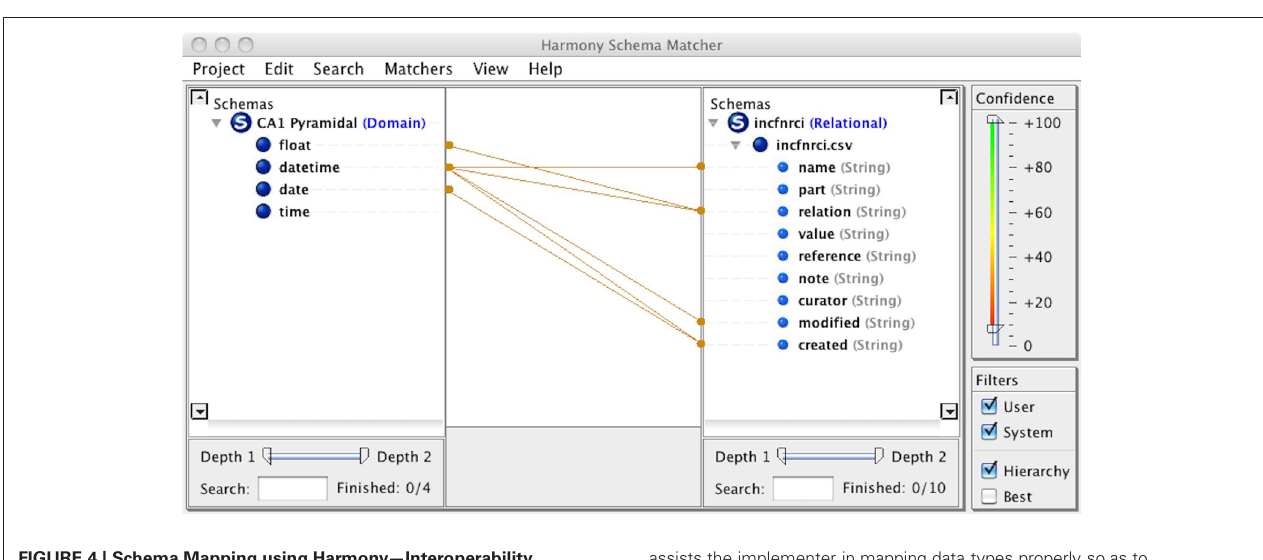
FIGURE 4 | Schema Mapping using Harmony—Interoperability among neuroinformatic resources is aided through synchronization and sharing of data. Schema matching across disparate informatic repositories is critical to this sharing. Harmony